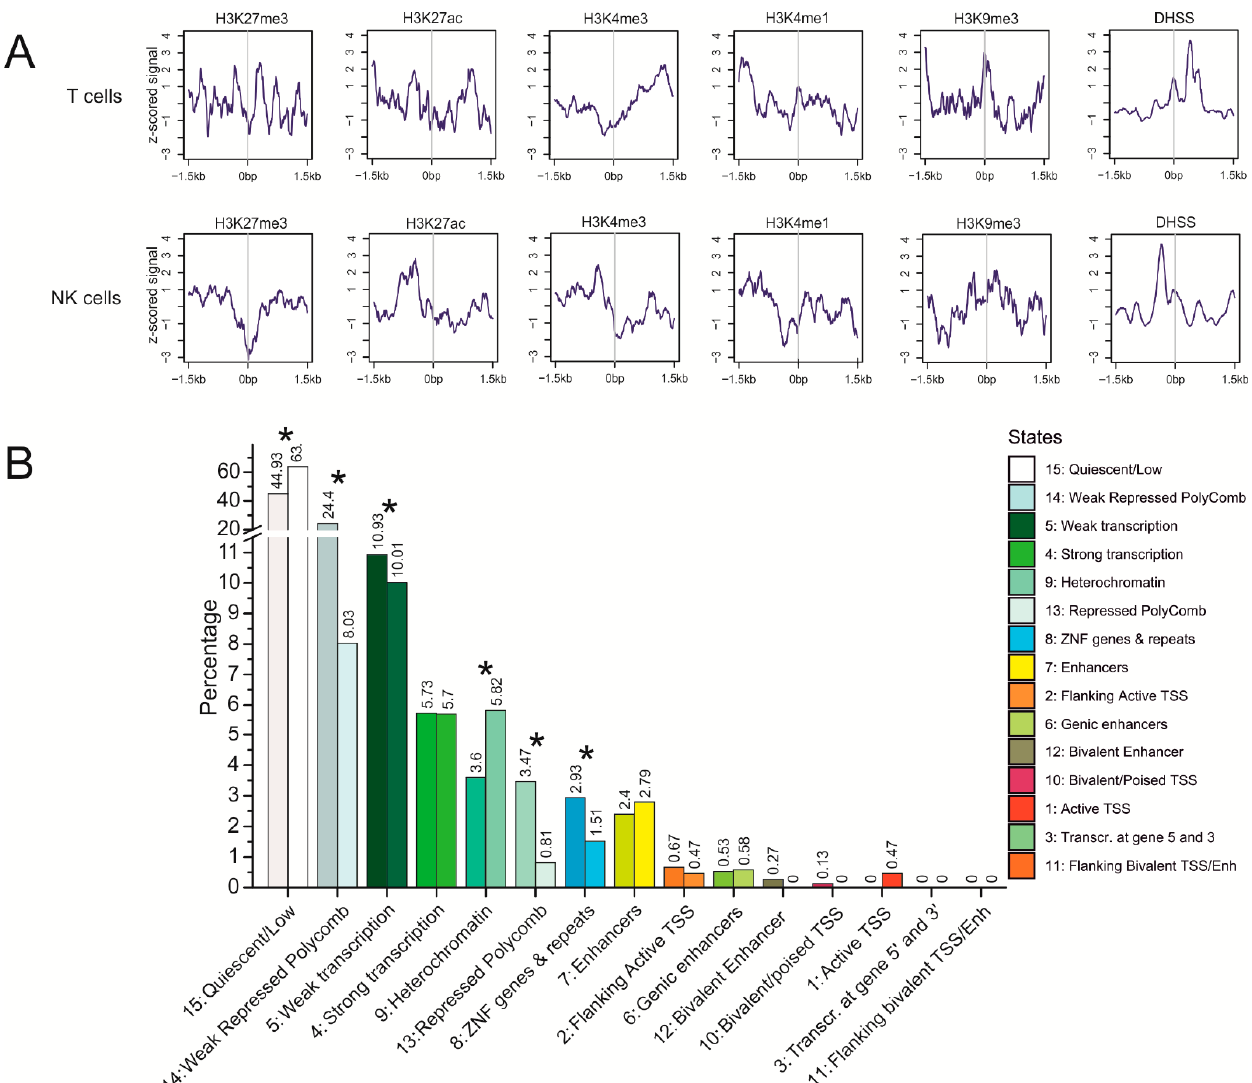
Figure 5. Properties of translocation targets in T cells and NK cells. ( A ) profiles of histone marks and DNase I hypersensitive sites (DHSS) around translocation sites. The z ‐ scored signals ± 1.5 kb around translocation targets are indicated. ( B ) the ratios of chromatin states (15 ‐ state model) at translocation sites in T cells (right, brighter bars) and in NK cells (left, darker bars). The labels present a state number and the percentage of the corresponding state. * p ‐ value < 0.0003.